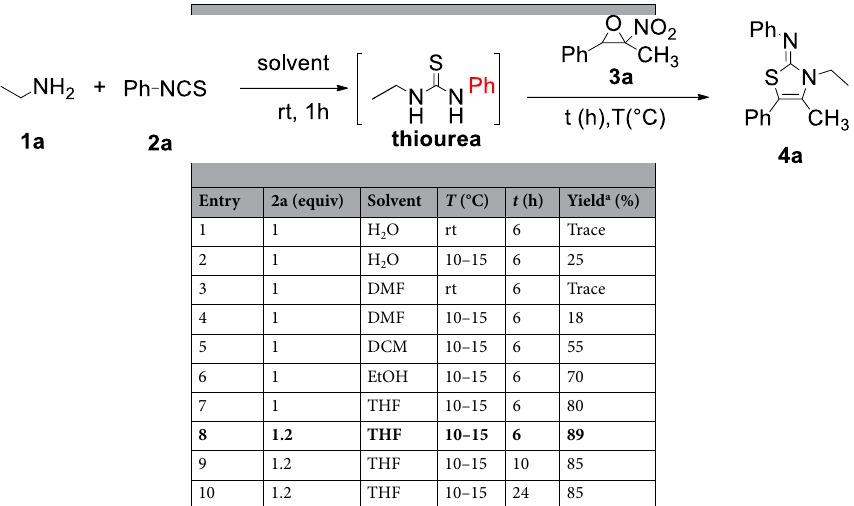
Table 1. Optimization of the reaction conditions. a Isolated